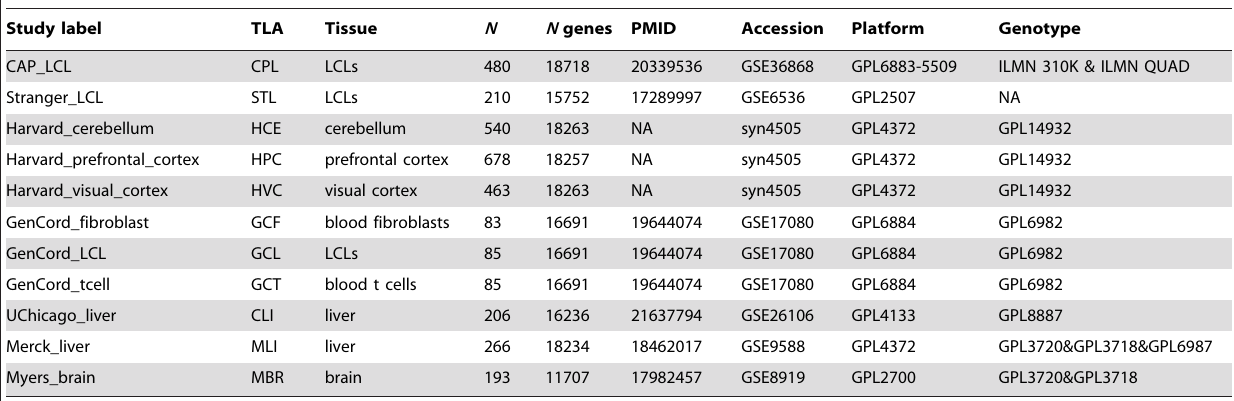
Table 1. Study Information.